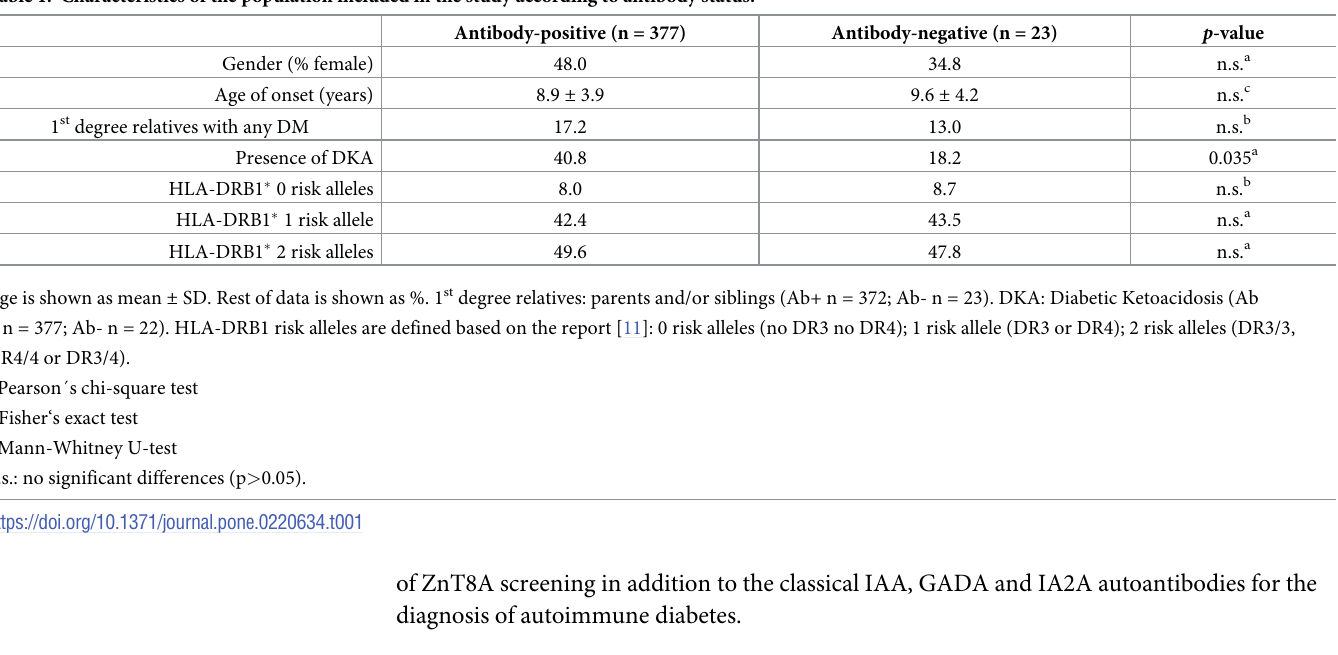
Table 1. Characteristics of the population included in the study according to antibody